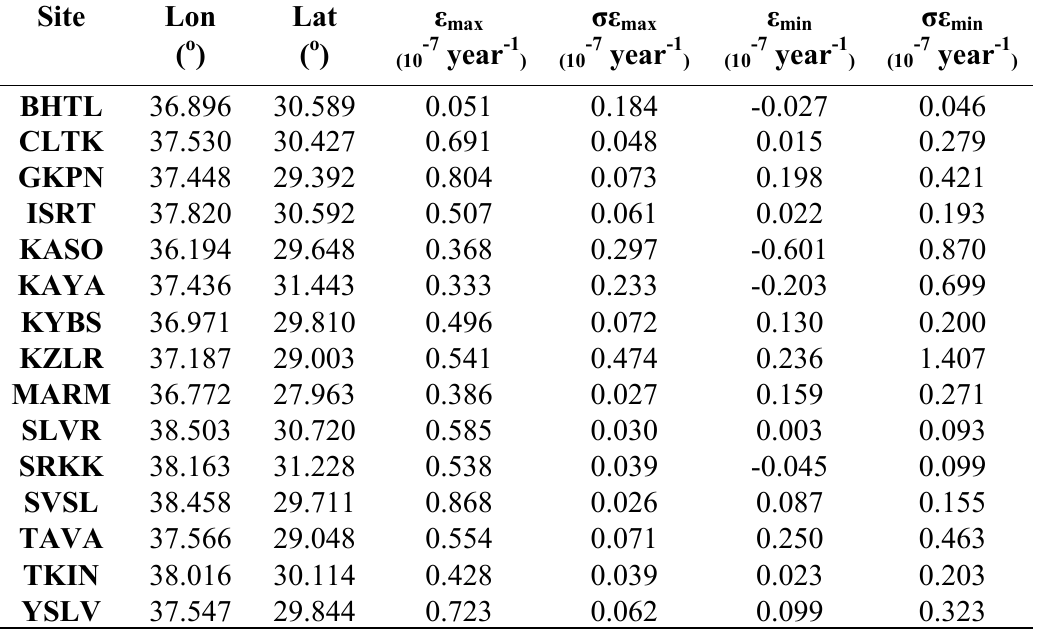
Table 2. Principal strains computed from GPS